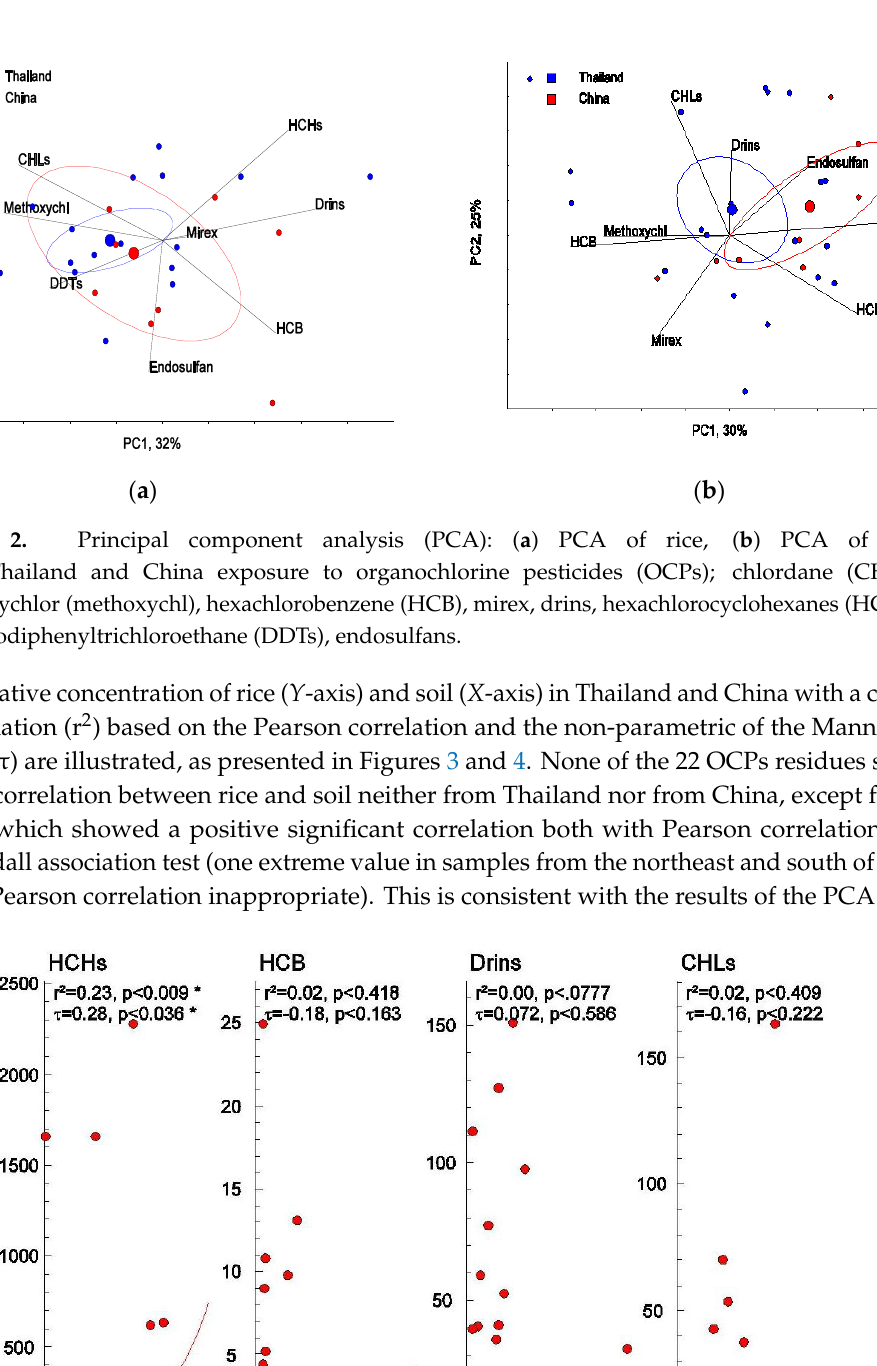
Figure 4. Concentration of individual OCPs (DDTs, methoxychlor, mirex, endosulfan) between rice ( Y -axis) and soil ( X -axis) in Thailand and China.